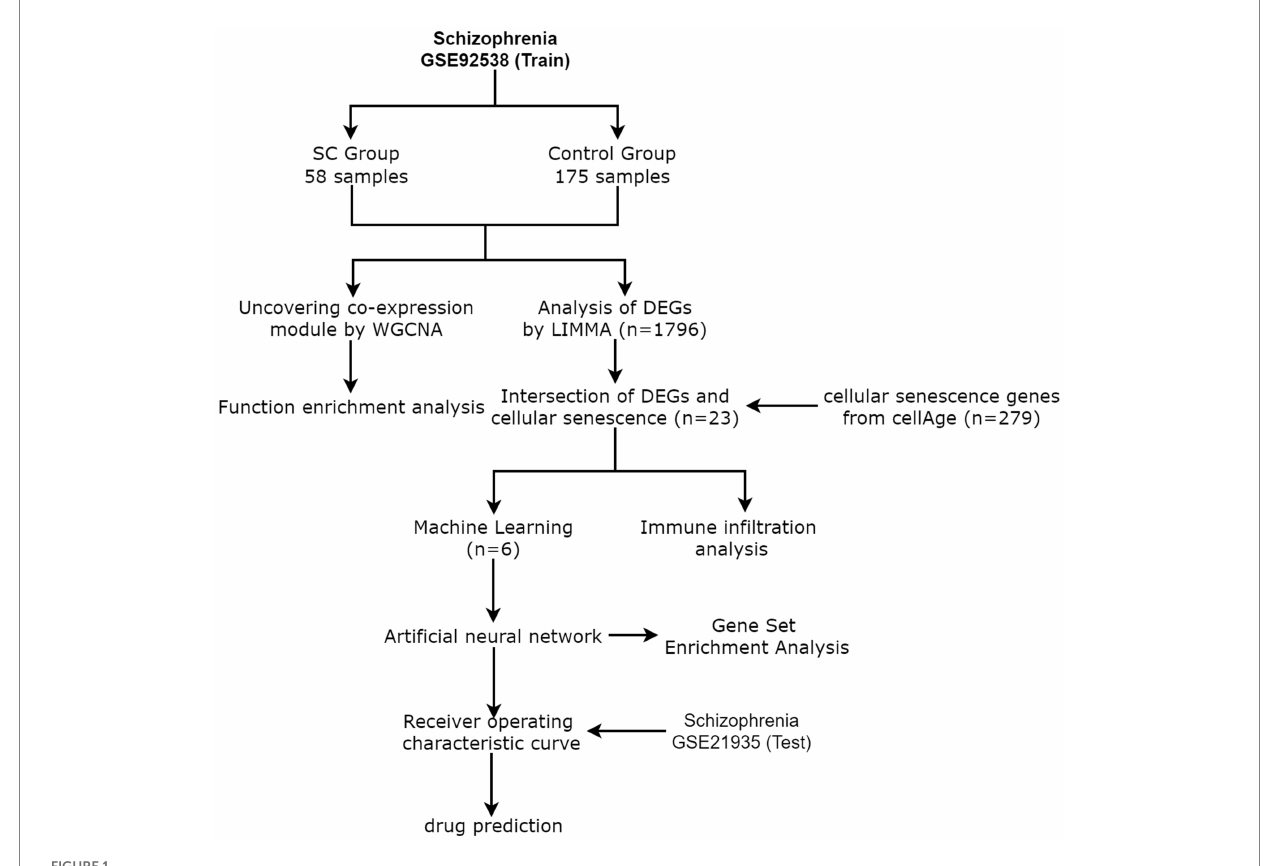
FIGURE 1 Flow Chart.